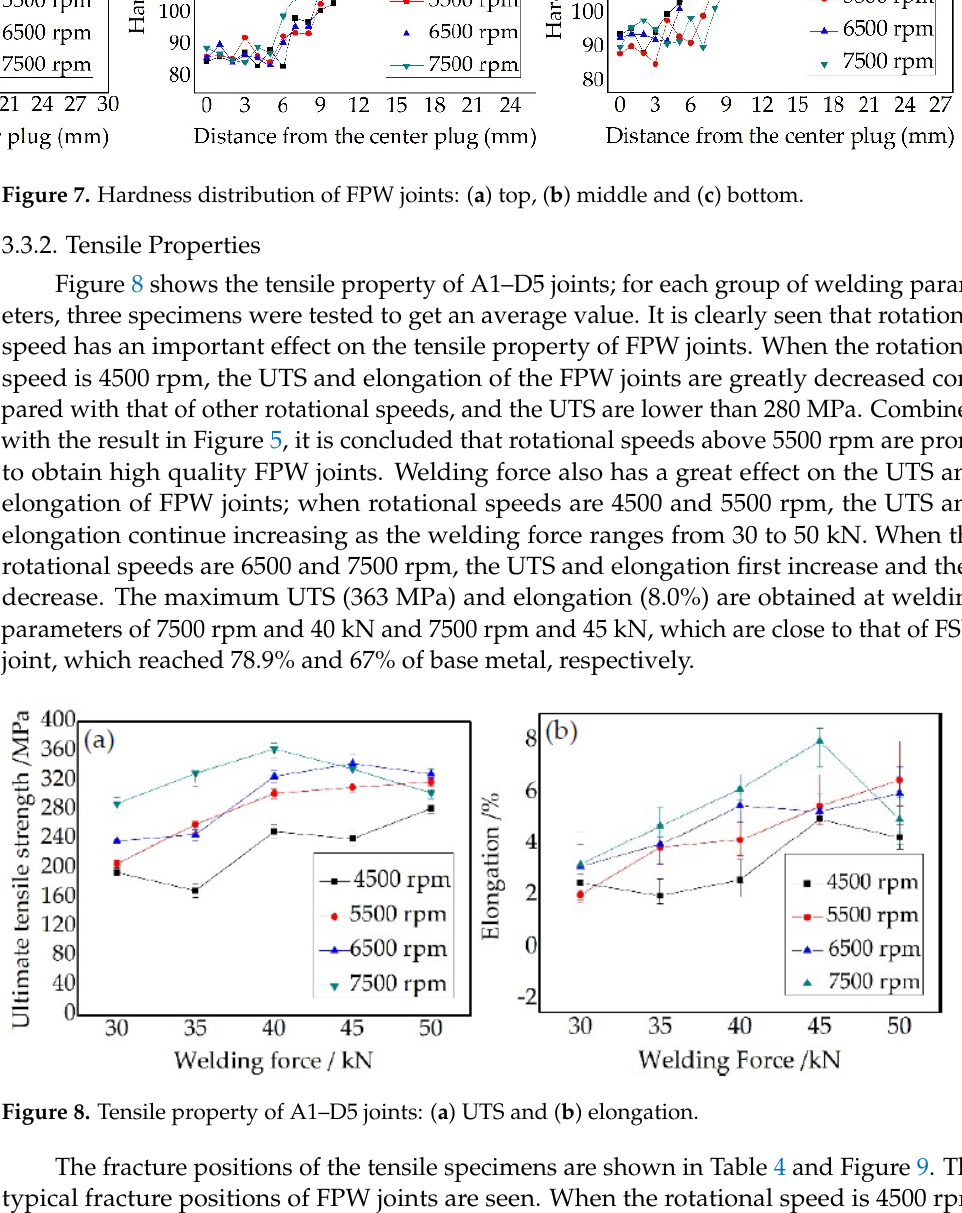
Figure 8. Tensile property of A1–D5 joints: ( a ) UTS and ( b ) elongation.